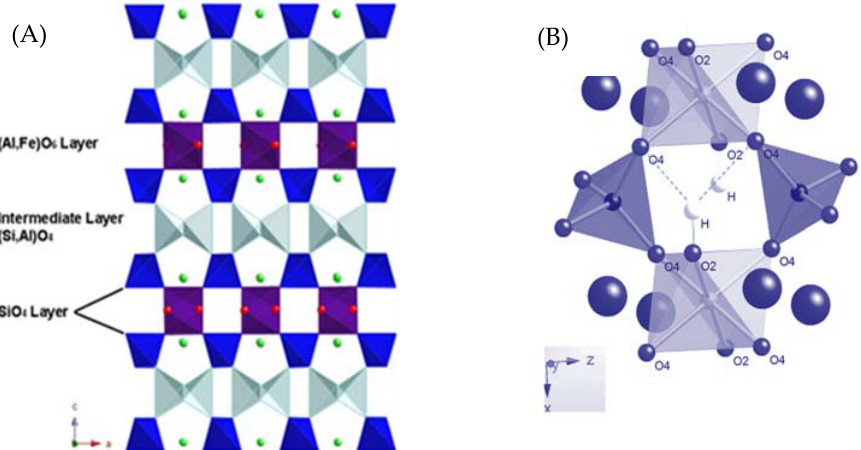
Figure 1. ( A ) The average structure of prehnite (P ncm ), as viewed along [010] with (Al,Fe)O 6 (purple); SiO 4 (dark blue); (Si 0.5 ,Al 0.5 )O 4 (light blue); Ca 2+ (green spheres). ( B ) Hydrogen positions viewed down [010]. Both figures were generated from crystallographic data reported in [9].